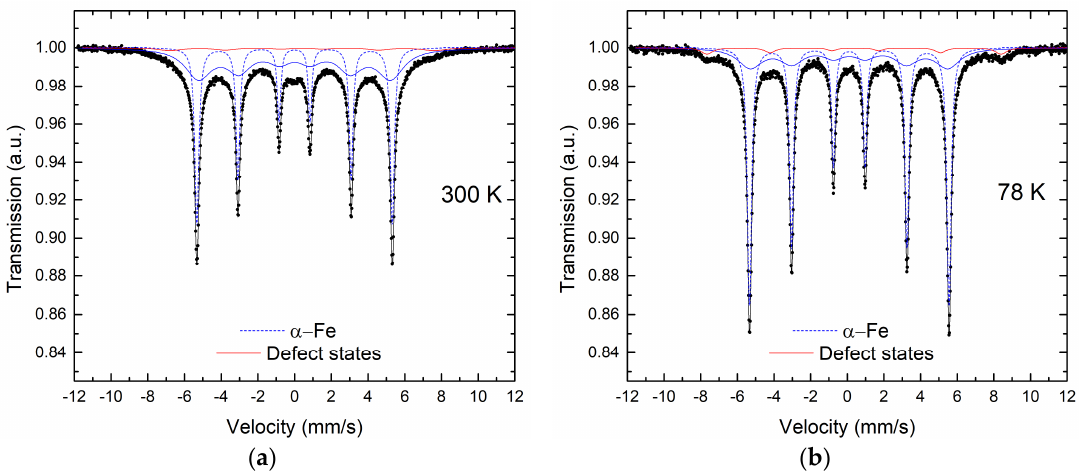
Figure 2. Mössbauer spectrum measured of the synthesized “Fe” powder at ( a ) room temperature (RT) and ( b ) 78 K.